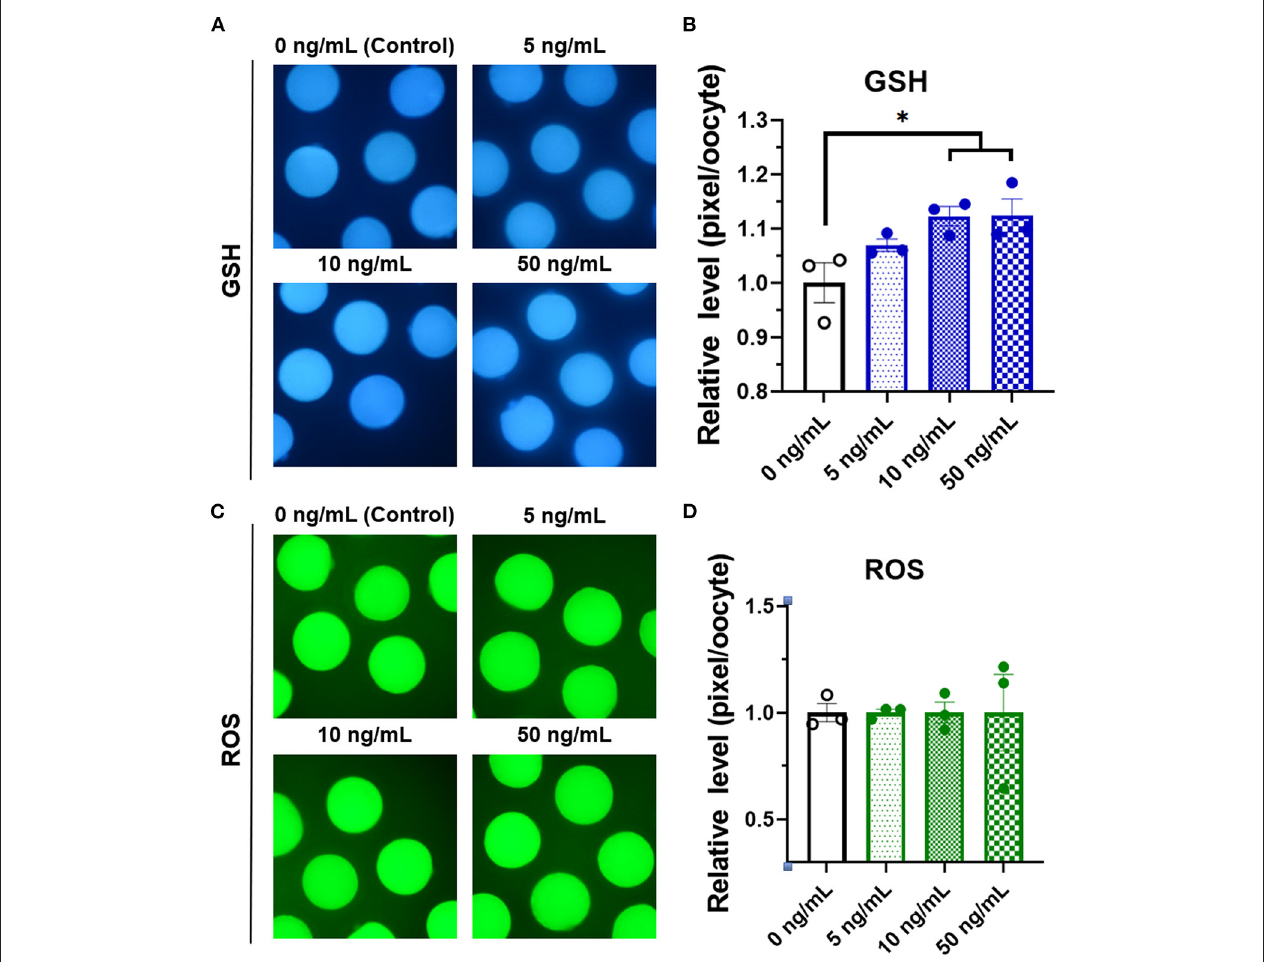
FIGURE 3 | Epifluorescent photomicrographic images of in vitro mature porcine oocytes. (A) Oocytes were stained with CellTracker Blue to detect intracellular levels of glutathione (GSH). Metaphase II oocytes derived from maturation medium supplemented with SCF (0, 5, 10, and 50ng/mL). (B) The relative levels of intracellular GSH in in vitro mature porcine oocytes among the SCF-treated groups. (C) Oocytes were stained with 2 ′ ,7 ′ -dichlorodihydrofluorescein diacetate to detect intracellular levels of reactive oxygen species (ROS). (D) The relative levels of intracellular ROS in in vitro mature porcine oocytes among the SCF-treated groups. Asterisks indicate statistical significance (* p < 0.05). Statistical significance was determined by one-way ANOVA. The experiments were performed in triplicate. Total number of examined oocytes: GSH samples, n = 240; ROS samples, n =